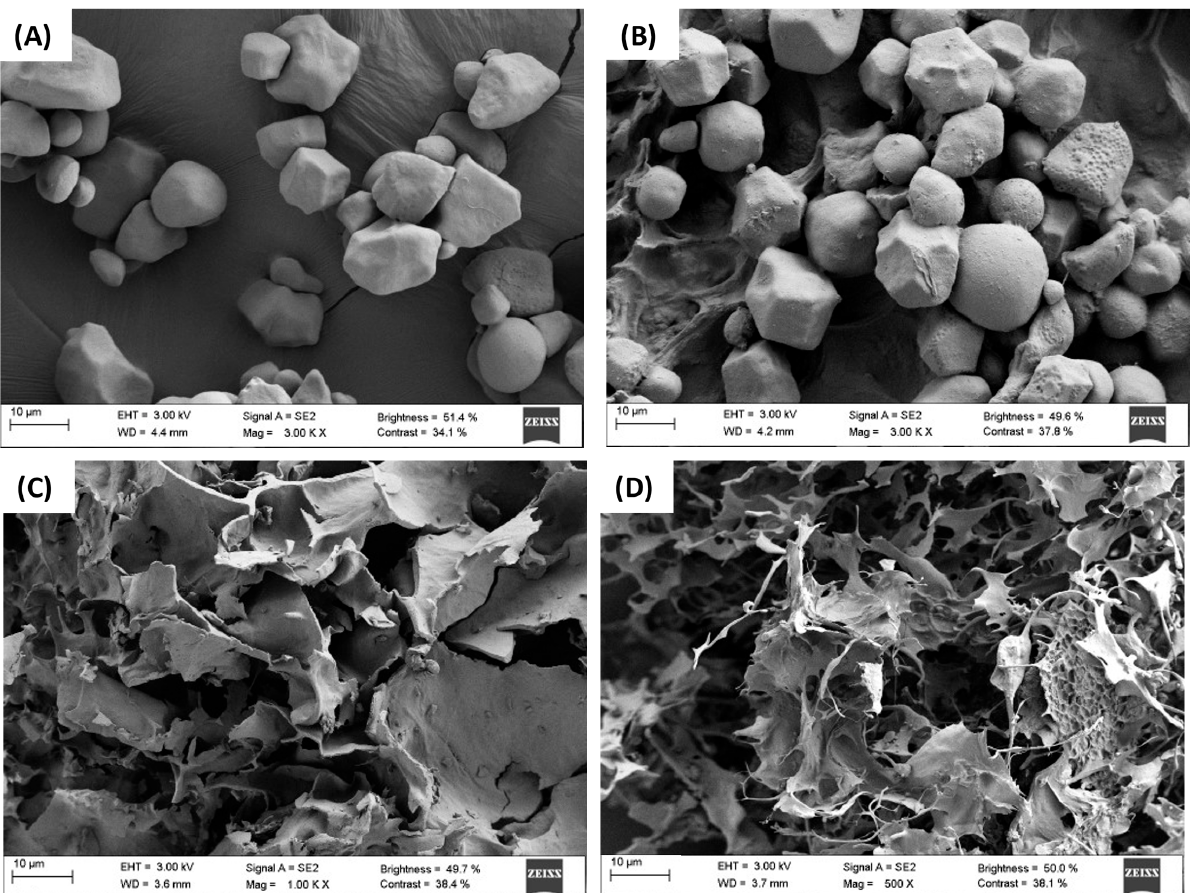
Figure 6. Cross-sectional morphologies of solid phase from CS ( A ) and AF–CS (1:1 ratio) samples (NT ( B ), GL ( C ), and CGL ( D )).